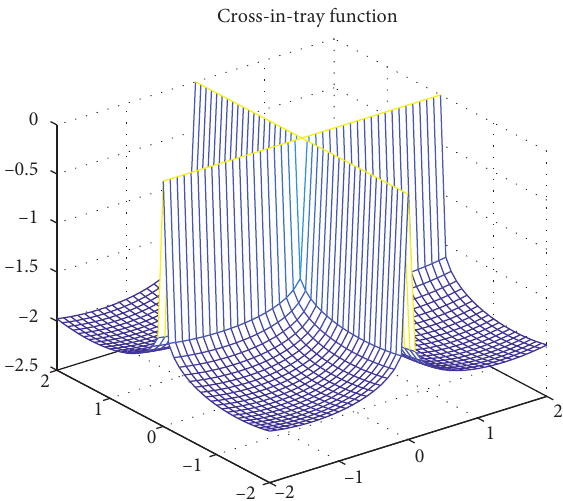
Figure 2: 3D surface plot of the cross-in-tray